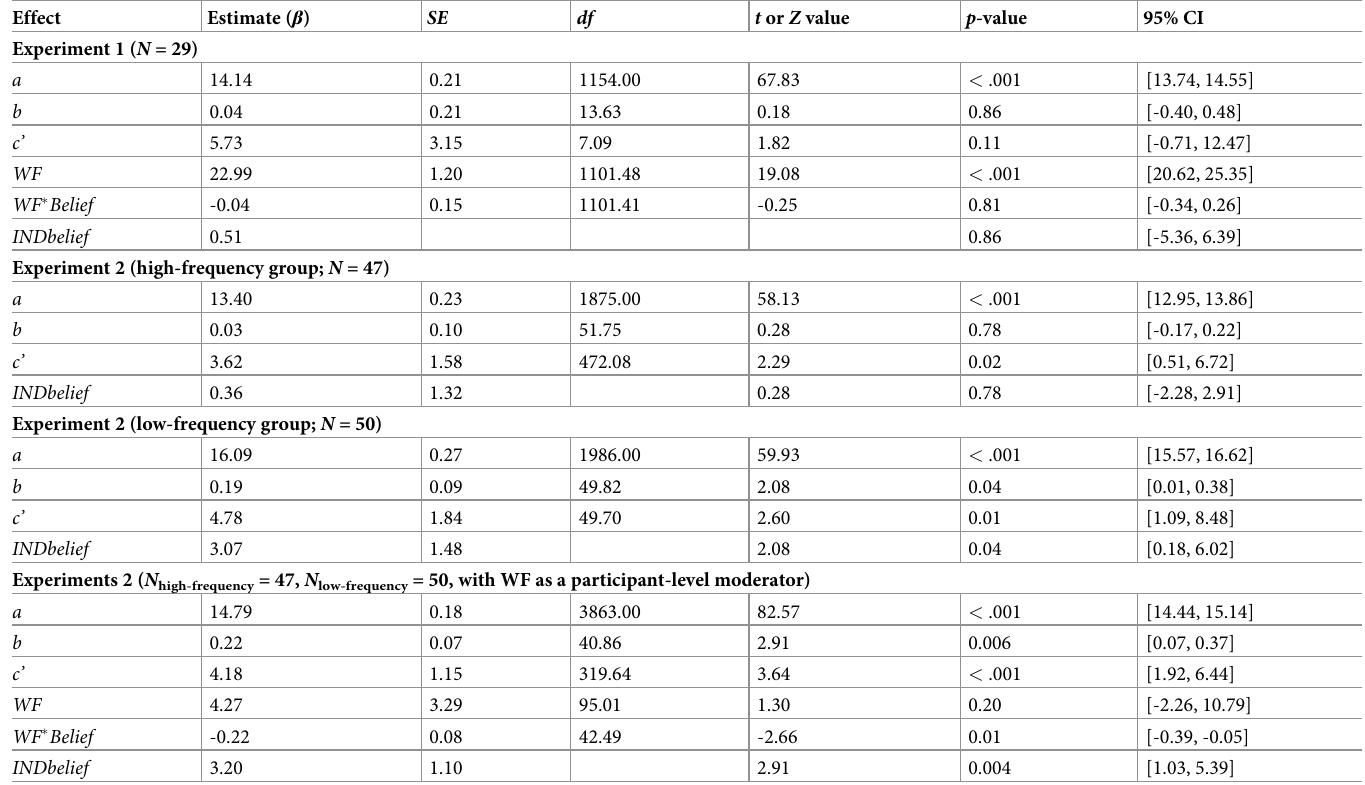
Table 2. Results from the multilevel mediation models in Experiments 1 and